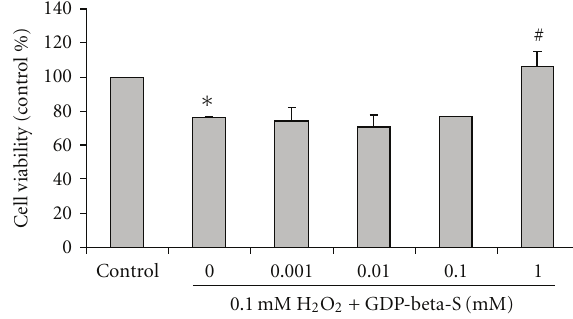
Figure 2: E ff ect of an inhibitor of G-protein activation, GDP- beta-S, on H 2 O 2 -induced reduction in cell viability in SH-SY5Y cultured cells. SH-SY5Y cells were treated with 0.001, 0.01, 0.1, and 1.0mM GDP-beta-S for 3 hours prior to incubation with 0.1 mM H 2 O 2 for another 24 hours. Cell viability was assessed using MTT assay and presented as percentage of untreated (0mM) control cells. The results are expressed as mean ± SEM of five independent experiments. The ANOVA was performed for statistical analysis ( ∗ P < . 05 compared with control and # P < . 05 compared with H treated